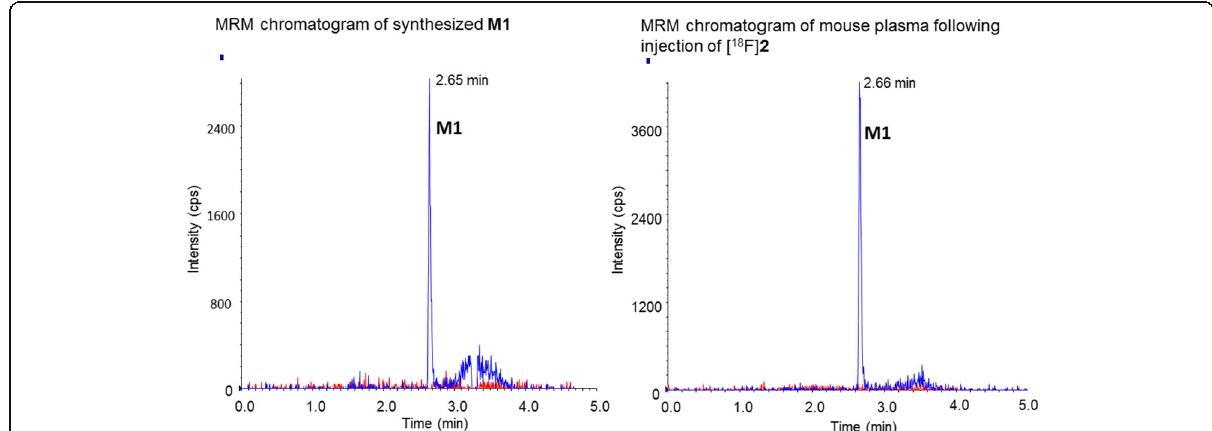
Fig. 3 LC-MS/MS spectra following carrier added administration of [ 18 F] 2 to SCID mice. MRM mass transitions 696.2 – 418.0 m/z (corresponding to 2 , red line) and 682.2 – 626.3 m/z (corresponding to M1 , blue line). Left chromatogram: LC-MS/MS analysis of synthesised M1 . Right